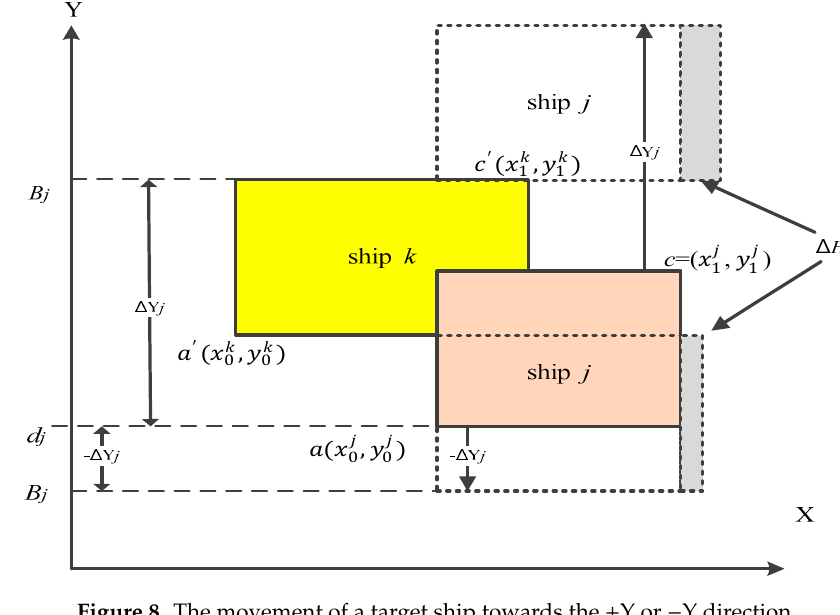
Figure 8. The movement of a target ship towards the +Y or − Y direction.